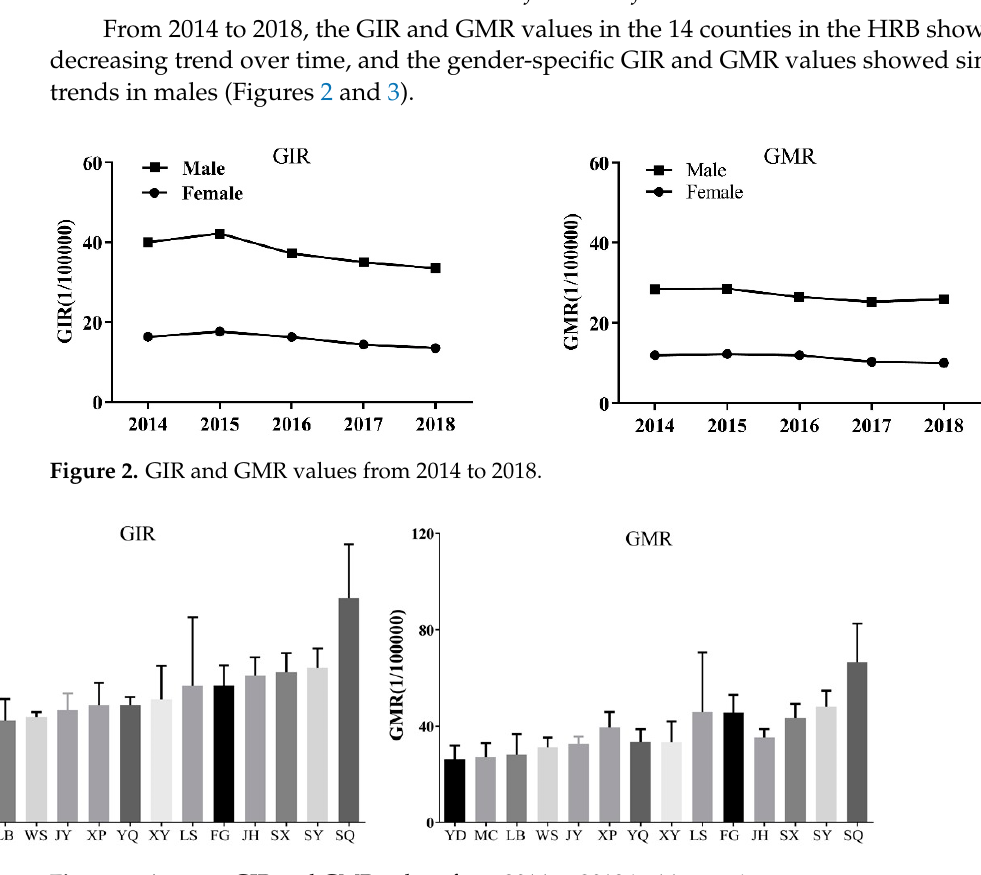
Figure 3. Average GIR and GMR values from 2014 to 2018 in 14